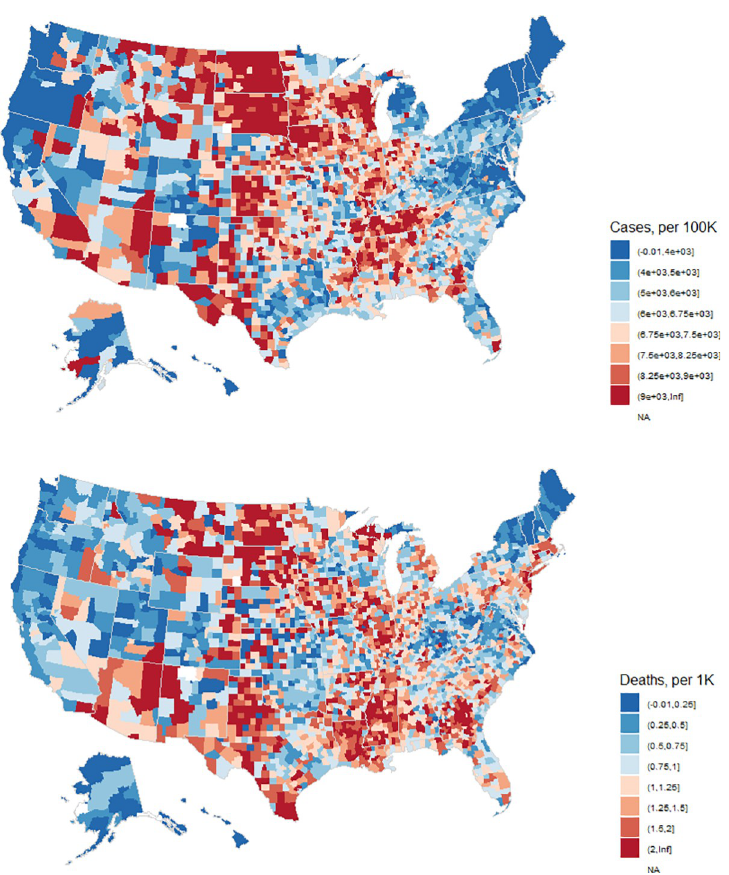
Fig 2. COVID-19 cases (per 100,000 residents) and deaths (per 1,000 residents) in US counties through December 31, 2020. Maps generated with usmap R package [28]. COVID-19, Coronavirus Disease 2019.